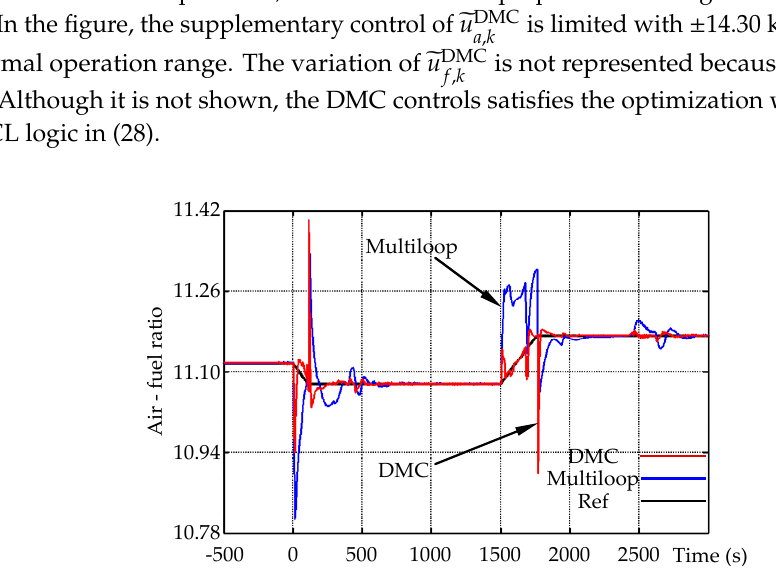
Figure 14. Comparison of air in 1000-MW plant.